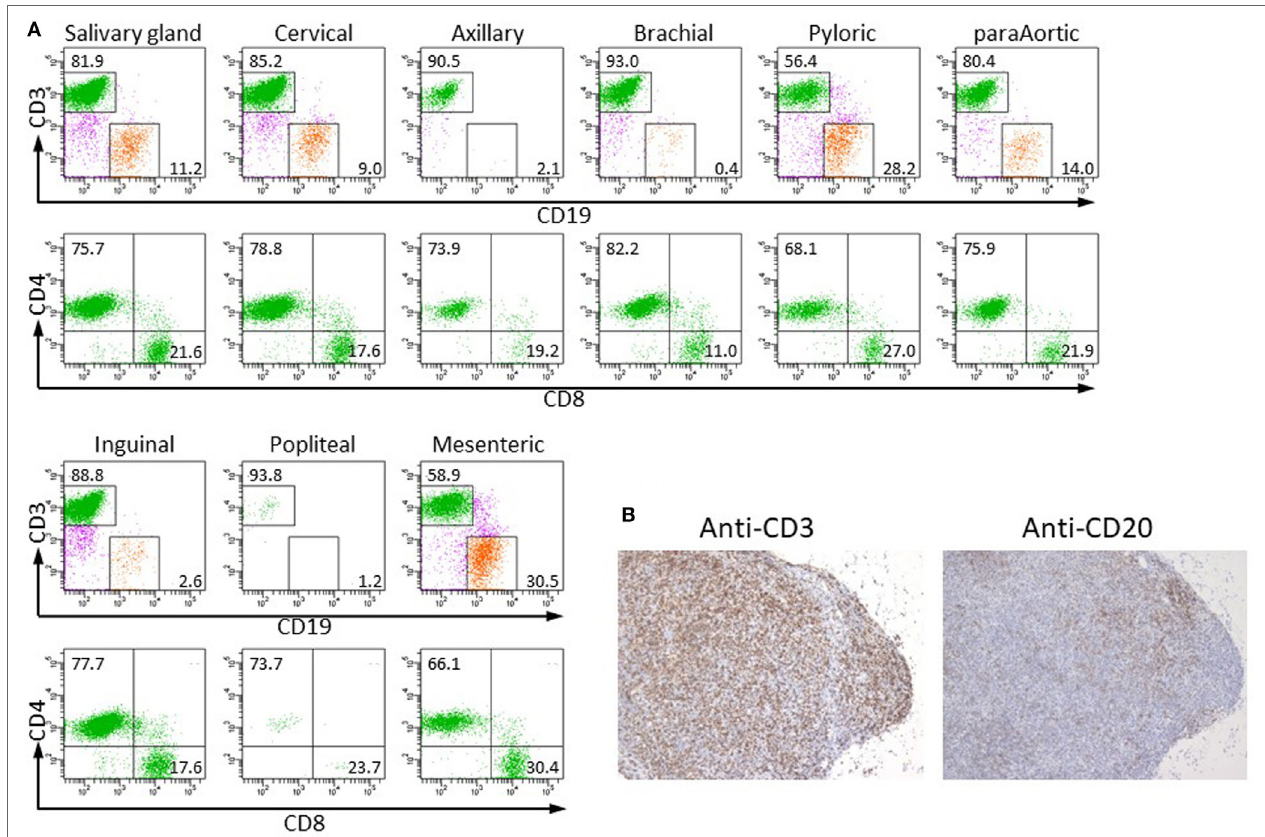
FigUre 3 | Colonization of restored lymph nodes (LNs) by human lymphocytes. (a) The indicated LNs were isolated from NOG-pROR γ t- γ c Tg mice at 20 weeks after hematopoietic stem cell transfer, and human lymphocytes were analyzed by fluorescence-activated cell sorting (FACS). A representative result from three different mice is shown. (B) Immunohistochemistry of mLNs. mLNs from the same mice used in (a) were fixed in formalin and sectioned after embedding in paraffin. Sections were stained with antihuman CD3 (left) and CD20 (right)